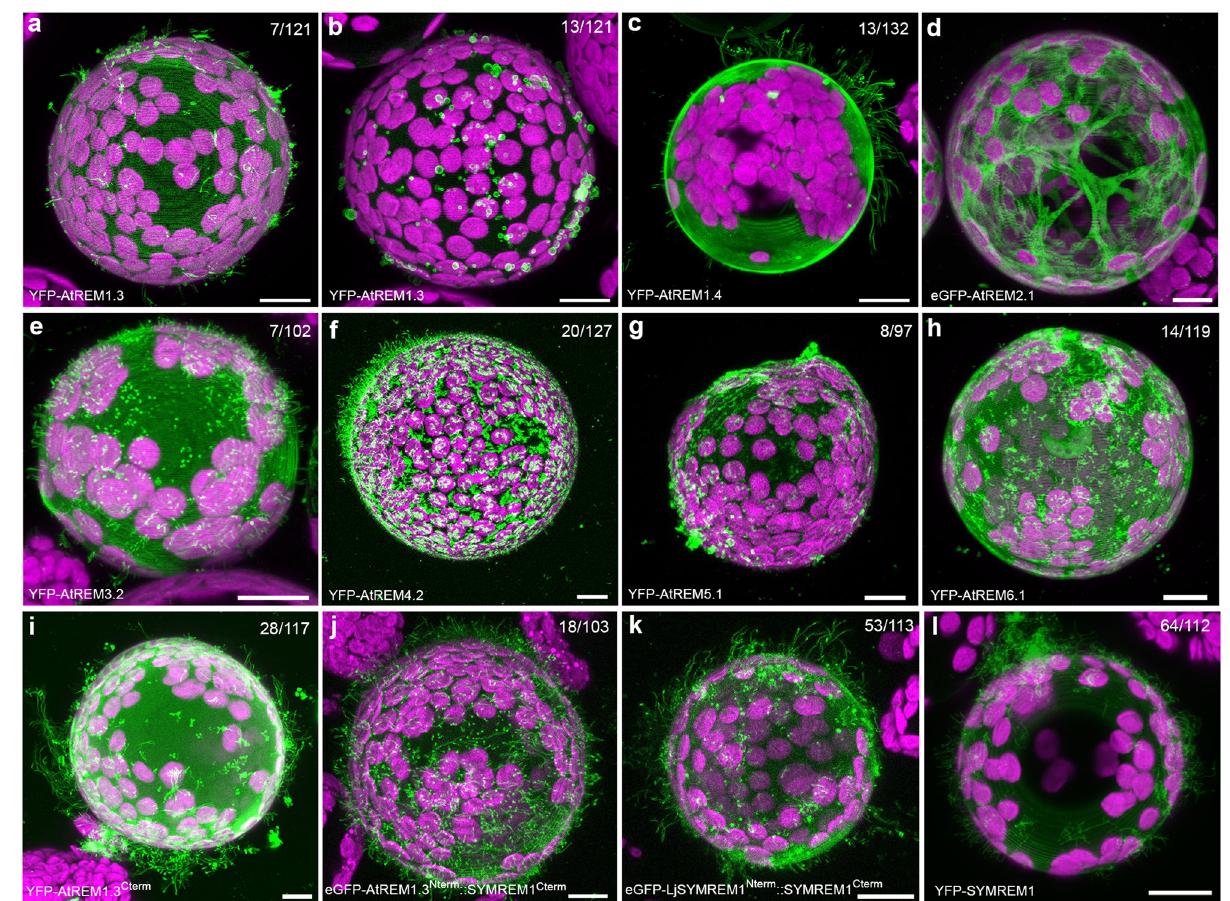
Fig. 7 | Remorin-induced membrane tubulation in protoplasts. a – h N. ben- thamiana leaf protoplasts ectopically expressing different remorins from the non- symbiotic plant Arabidopsis thaliana covering all sub-groups of the Arabidopsis remorin family. AtREM1.3 ( a , b ), AtREM1.4 ( c ), AtREM2.1 ( d ), AtREM3.2 ( e ), AtREM4.2 ( f ), AtREM5.1 ( g ), AtREM6.1 ( h ). i – k Membrane tubulation activity was also assessed for a N-terminally truncated variant of AtREM1.3 (AtREM1.3 Cterm , i ), a chimeric protein comprised of the AtREM1.3 N-terminal and the SYMREM1